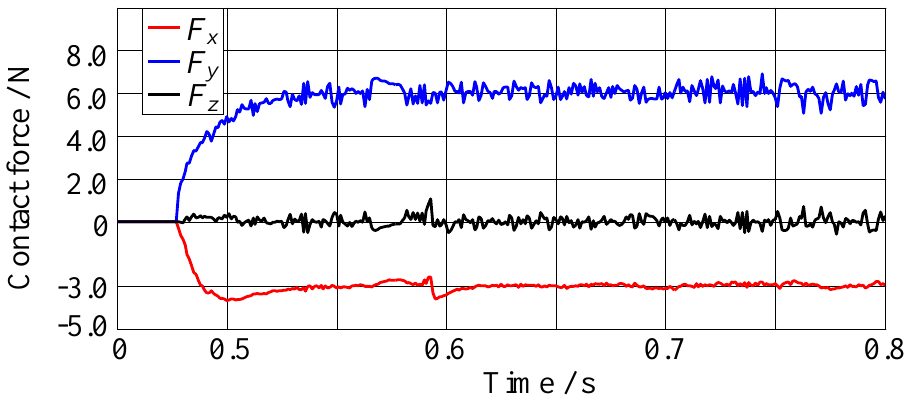
Figure 15. The force tracking results when environment stiffness is 80,000